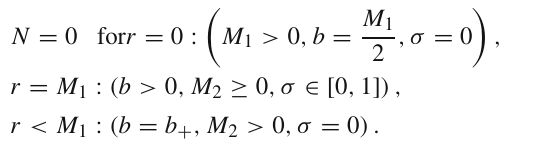
of the metric parameters. Blue curves are the zero of the characteris- tics frequencies. (The characteristic frequencies are null ω ± = 0 for √ (cid:25) 2 M , with M > 0 and ∀ J ). In the plane J − r , the bundle is null r = (cid:7) M (cid:25) 2 /( 1 − (cid:25) 2 ω 2 ) , red curves are the (non-rotating solutions) for r = horizons curves in the extended